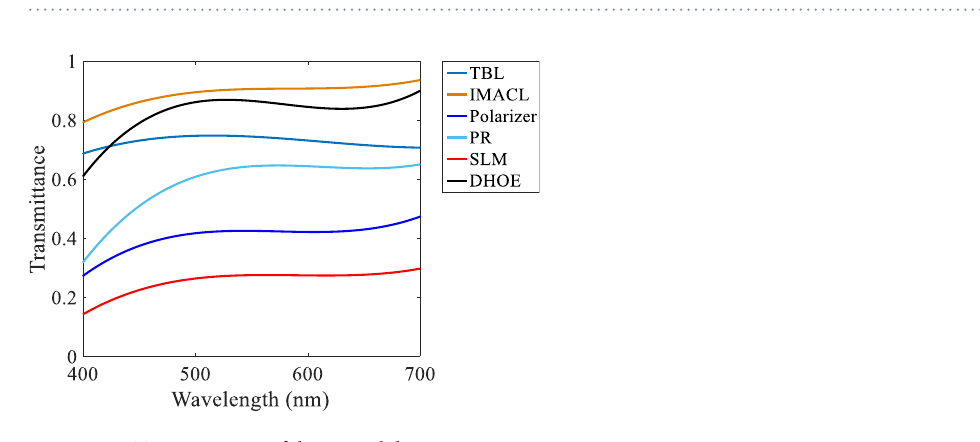
Figure 10. Transmittance of the optical